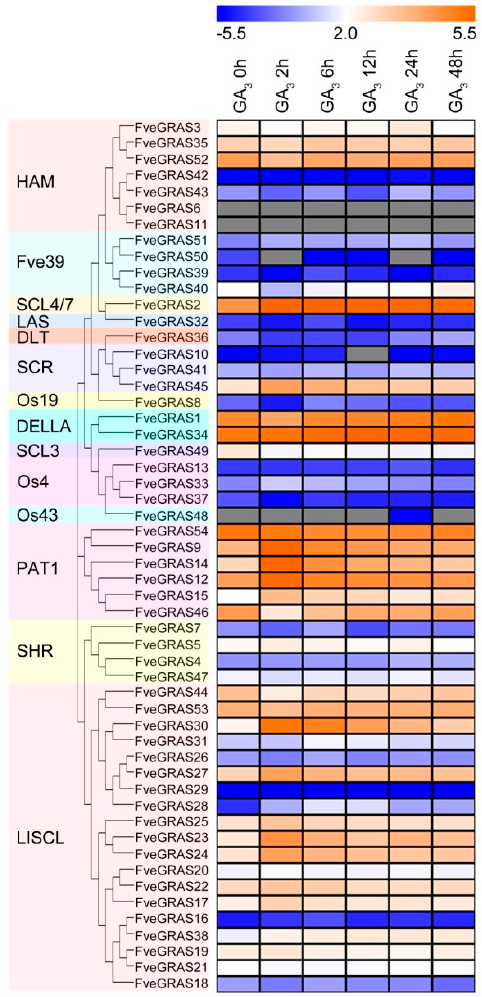
Figure 8. Expression changes of GRAS genes of woodland strawberry under GA 3 treatment. Woodland strawberry variety “Hawaii 4” seedlings were used for GA 3 treatment. FPKM values were in Supplementary Table S10, and the heat map showed log2 level.